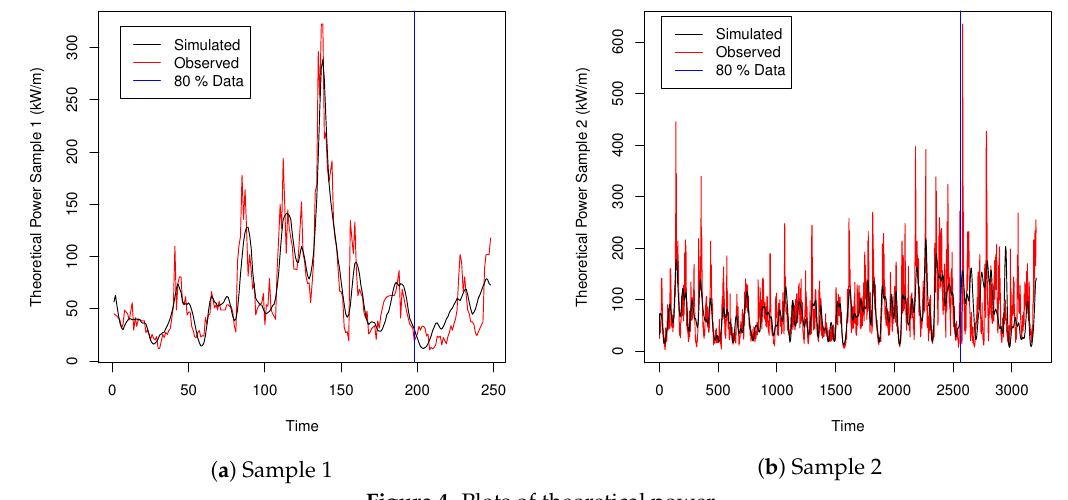
Figure 4. Plots of theoretical power.